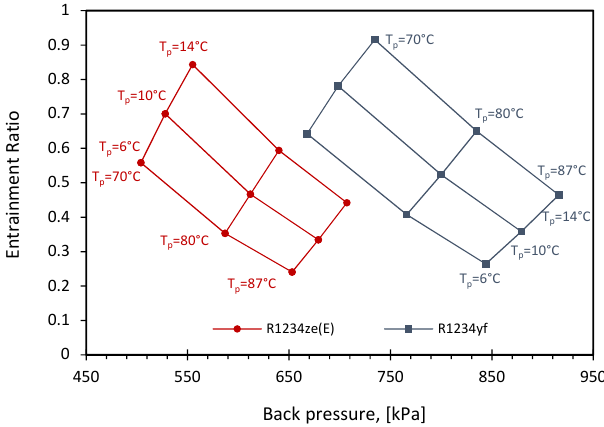
Figure 10. Performance map of the ejector based on CFD data.